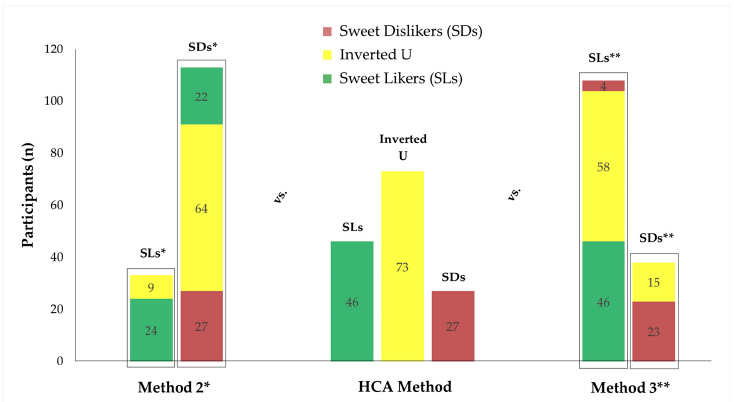
Figure 6. Comparison of the distribution of sweet taste liker phenotypes in our study sample when different classification methods were used. Method 2 (rating the 1 M sucrose solution or not as the most pleasant) and Method 3 (rating the 0.5 M sucrose solution higher than 0 or not) were, by definition, limited to a two-response group phenotyping outcome (binomial distribution), while HCA method (rating the 1 M sucrose solutions higher than +15, lower than − 15, or between − 15 and +15) allowed for the identification of three distinct sweet taste liker phenotypes. 133 participants (77.4%) versus